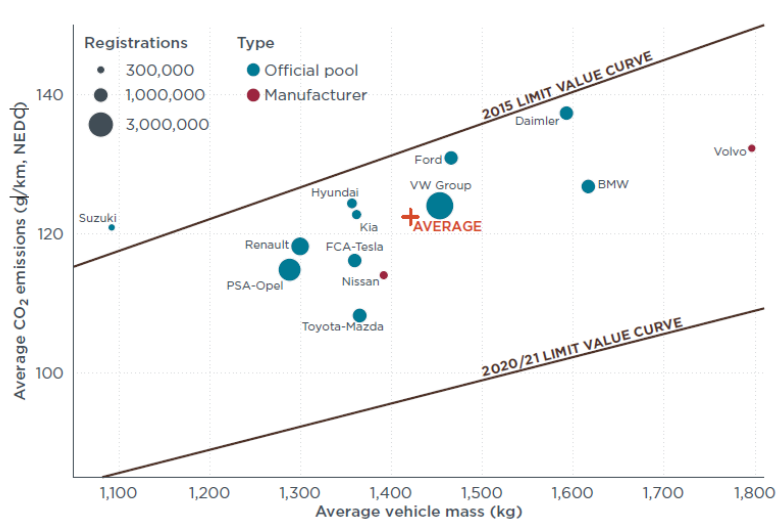
Figure 2. Average road emissions for the range of models sold in relation to manufacturers and emission limits [5].